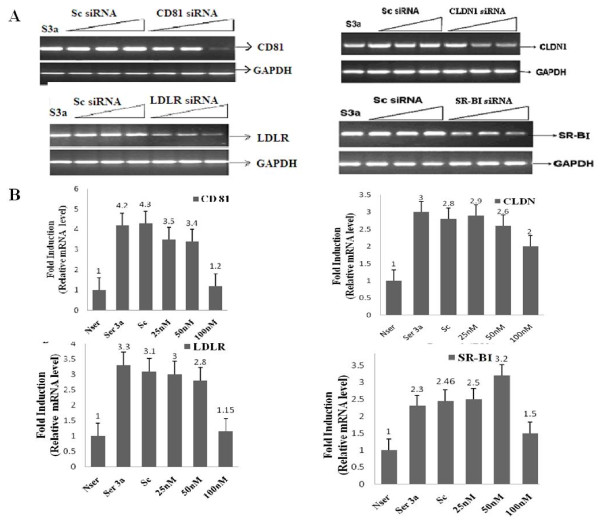
Silencing of gene expression of HCV receptors by their specific siRNA in a dose dependent manner. Huh-7 cells were infected with HCV-3a serum (S3a) along with or without 25 nM, 50 nM and 100 nM of siRNAs against HCV receptors CD81, LDLR, CLDN1 and SR-BI and scrambled (Sc) siRNA for 48 hrs. The scrambled (Sc) siRNA has nonspecific sequence with no homology to any known cellular genes. A) Semi-quantitative PCR analysis of gene expression of CD81, LDLR, CLDN1 and SR-BI using serial doses (25 nM, 50 nM and 100 nM) of scrambled siRNA or the specific siRNA siCD81, siCLDN, siLDLR, or siSR-BI respectively. B) Real-time PCR analysis indicating fold reduction of CD81, CLDN1, LDLR, and SR-BI gene using serial doses (25 nM, 50 nM and 100 nM) of scrambled siRNA or specific siRNAs of siCD81, siCLDN, siLDLR or, siSR-BI respectively.